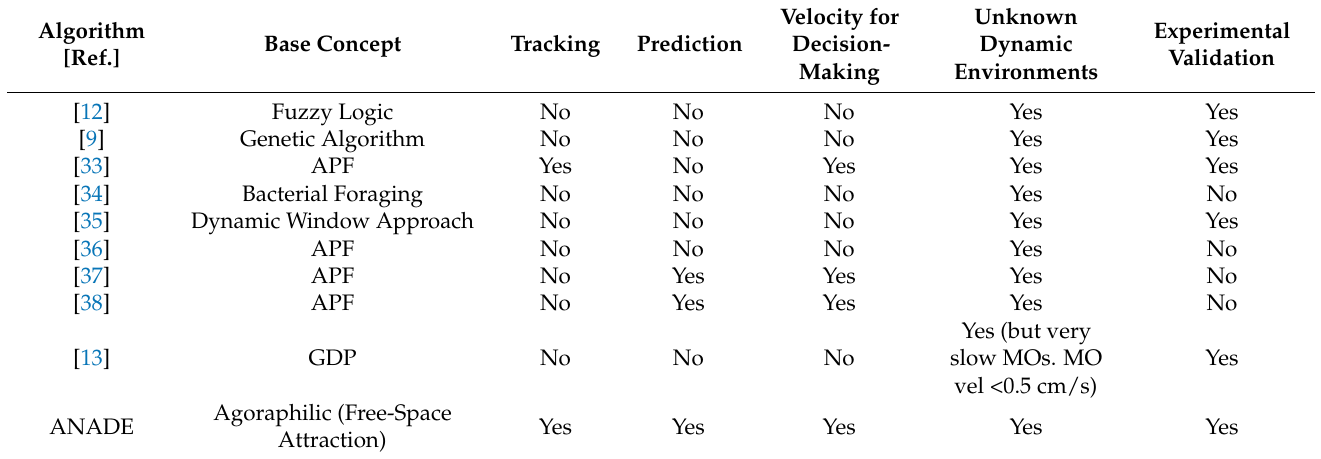
Table 4. A qualitative comparison between the proposed navigation algorithm with other